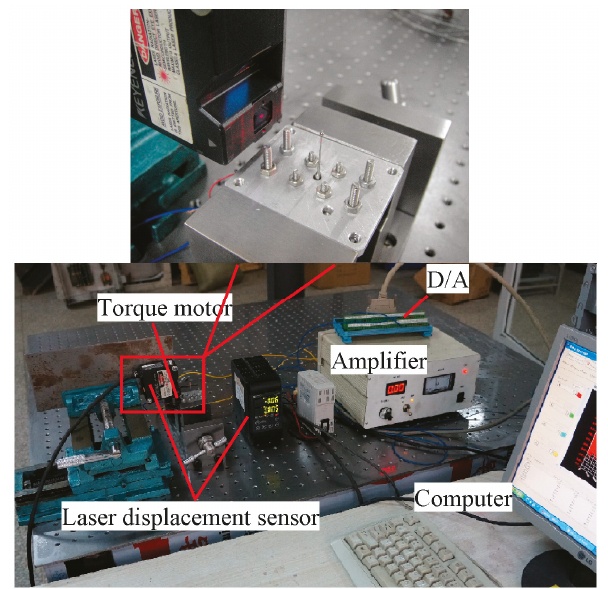
Figure 4. Experimental setup for vibration testing of the armature.